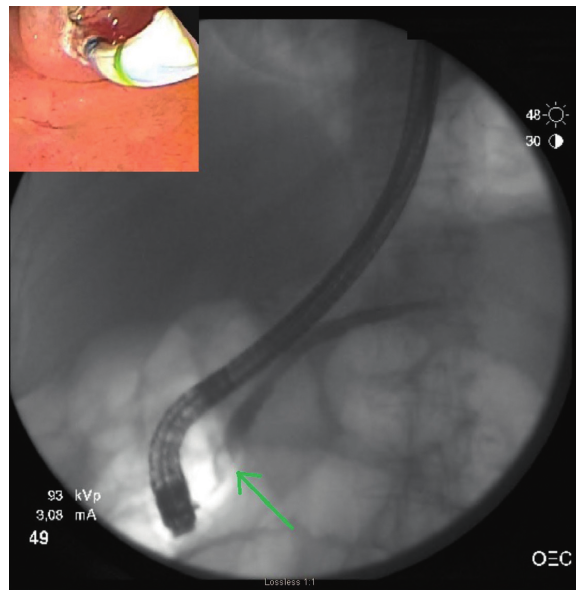
Figure 1: Selective cannulation of minor papilla and stone in the pancreatic duct.